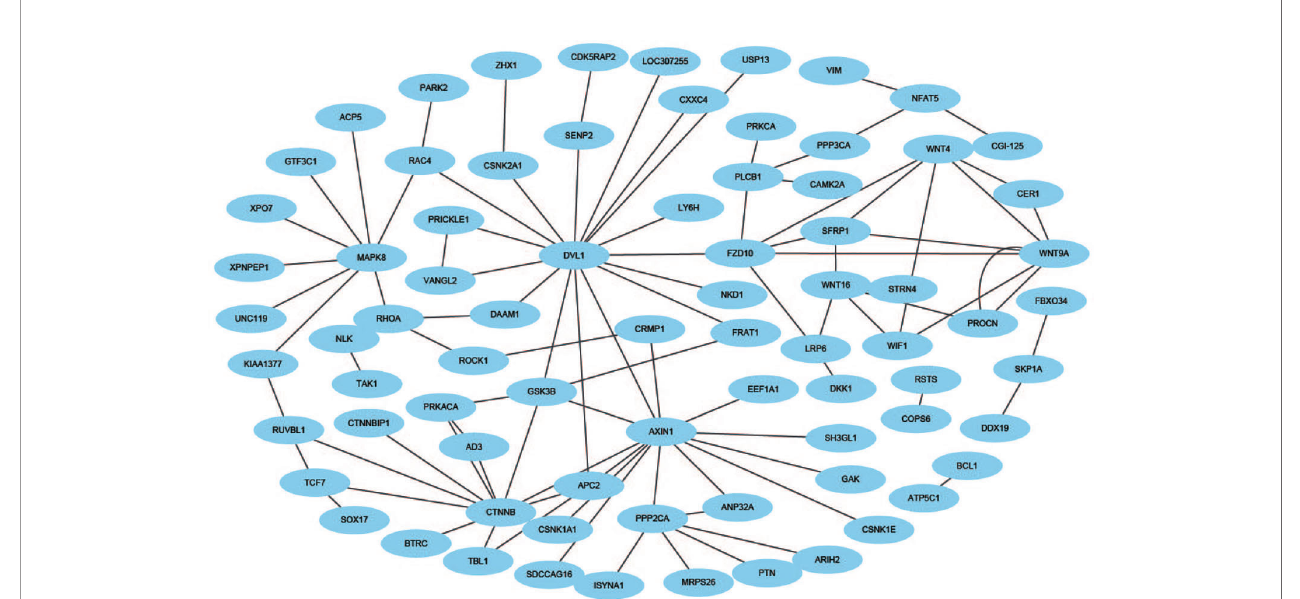
FIGURE 8 | The prediction results of cross-connection network of Wnt-related pathway.